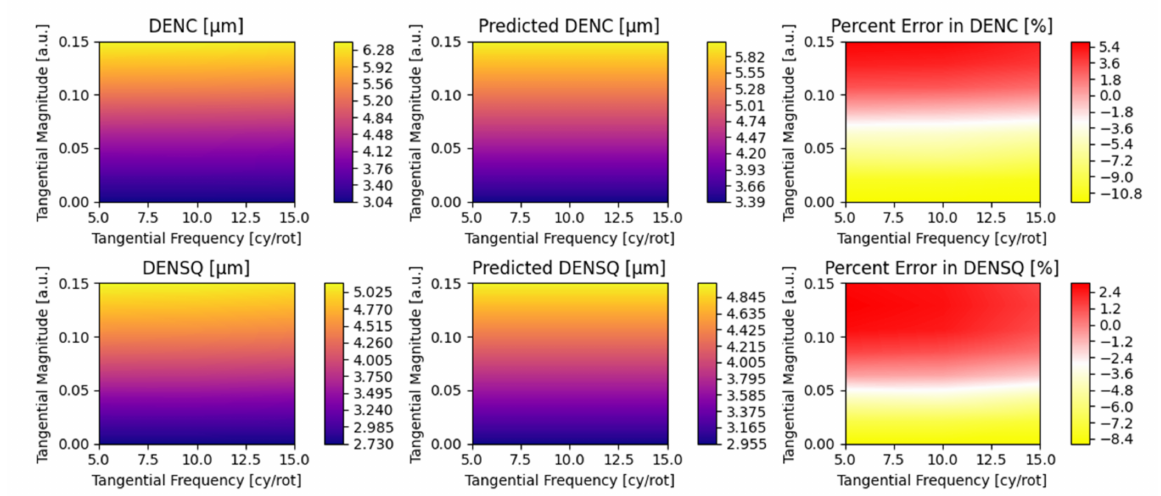
Figure A18. Tangential Frequency vs. tangential magnitude. ( η = ζ = δ = 0, ξ = 15, σ = 0.05, θ = 15 ◦ ).